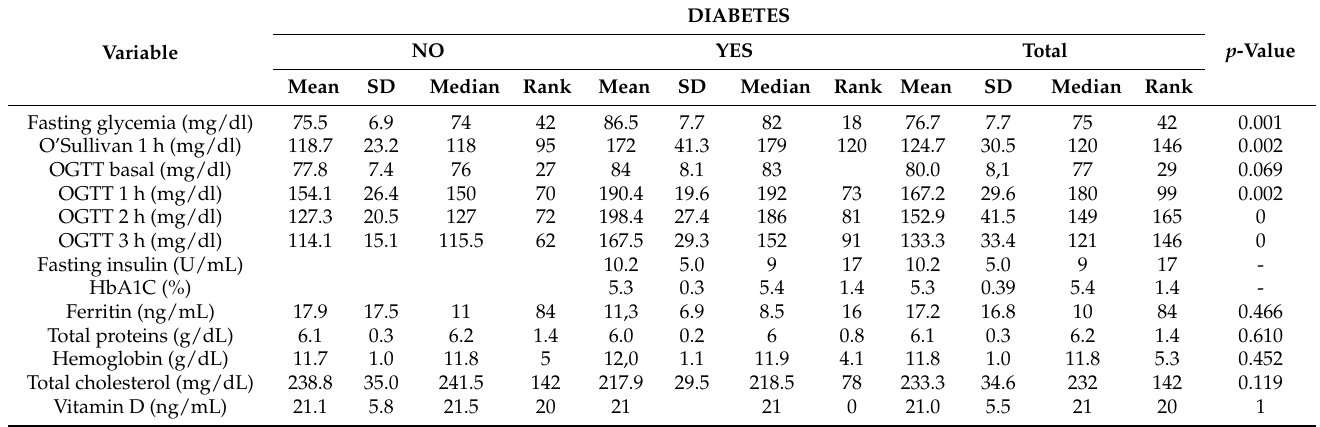
Table 1. Biochemical parameters of the pregnant women with GDM and those with normoglycemia, and statistically significant differences.